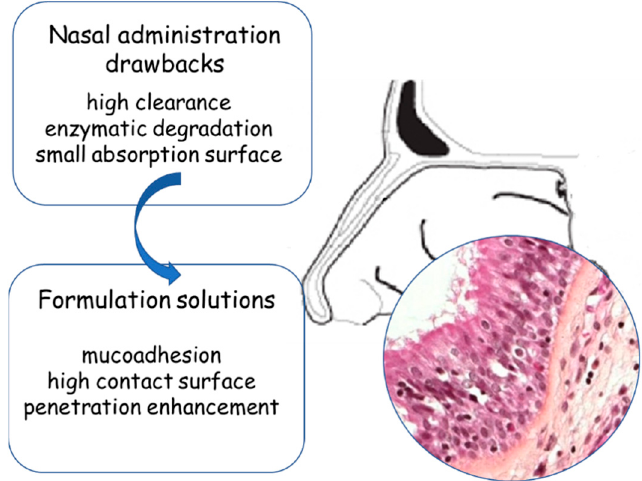
Figure 1. The nose as a route for the administration of drugs.